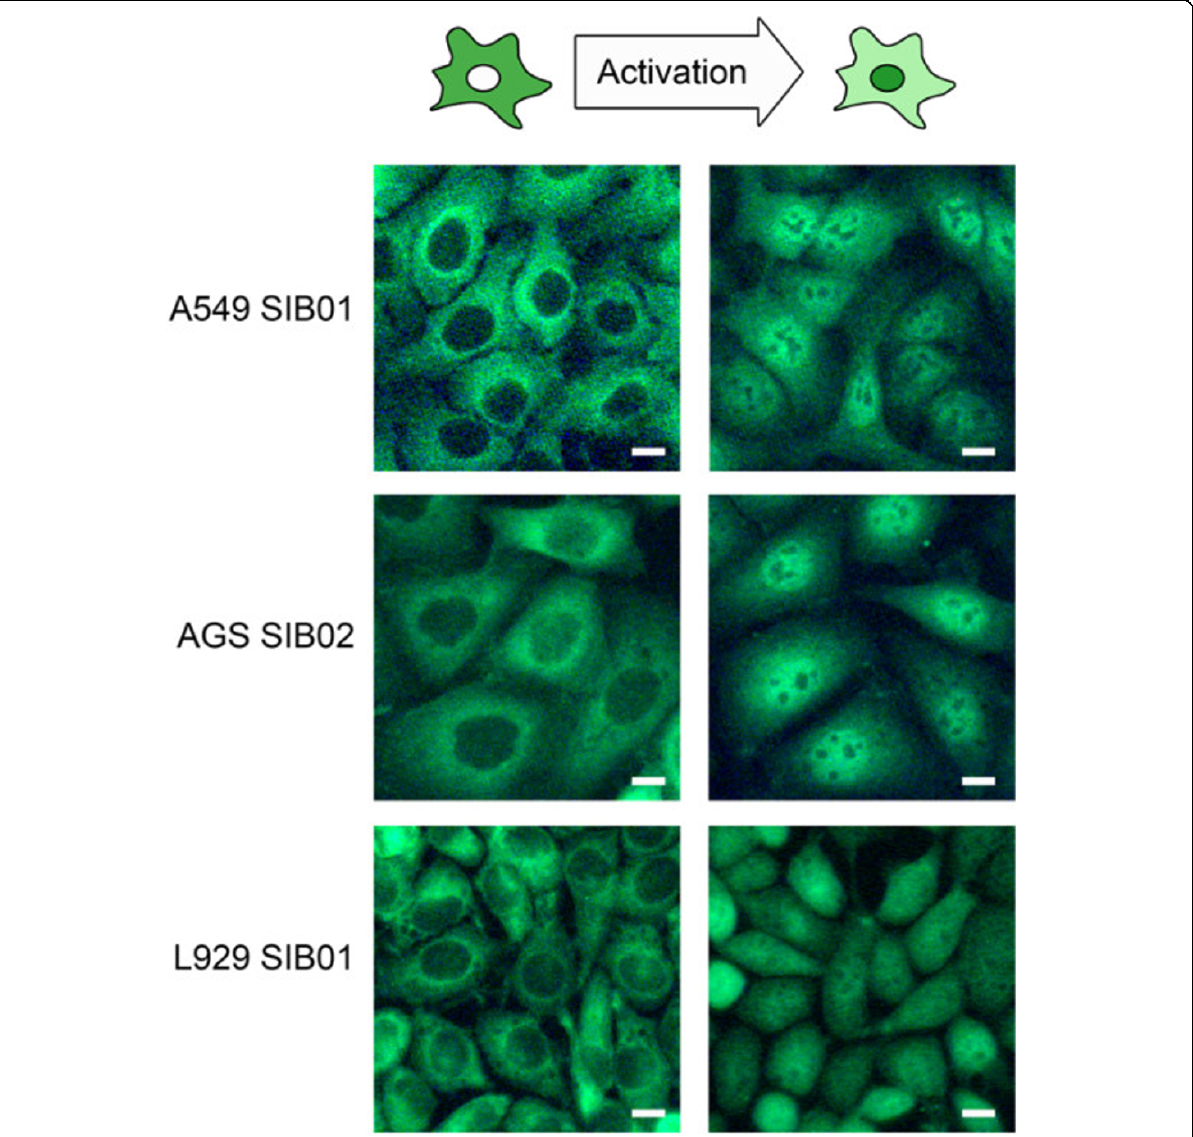
Figure 1 p65-GFP reporter cells A549 SIB01, AGS SIB02 and L929 SIB01 . Cells were seeded in 96-well plates and either left untreated (non- activated) or activated with TNF a (10 ng/ml) for 30 min. Cells were fixed and pictures were taken with a Leica DMR Microscope. Representative cells are shown. Scale bar = 10 μ